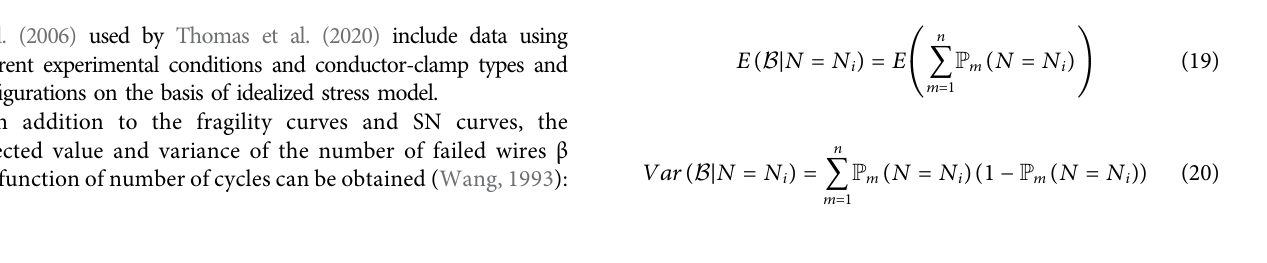
Frontiers in Built Environment |